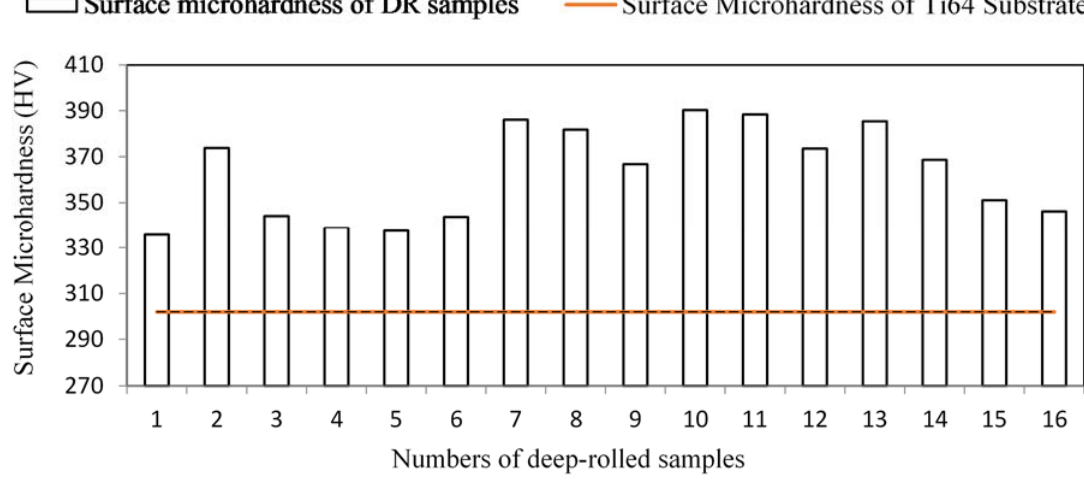
Figure 6. Comparison of the surface microhardness of DR-treated Ti64 with the non-treated Ti64. The microhardness of the non-treated Ti64 is represented by a horizontal line at 302 HV. The DR parameters of the 16 samples are in the embedded legend of Figure 5 and Table